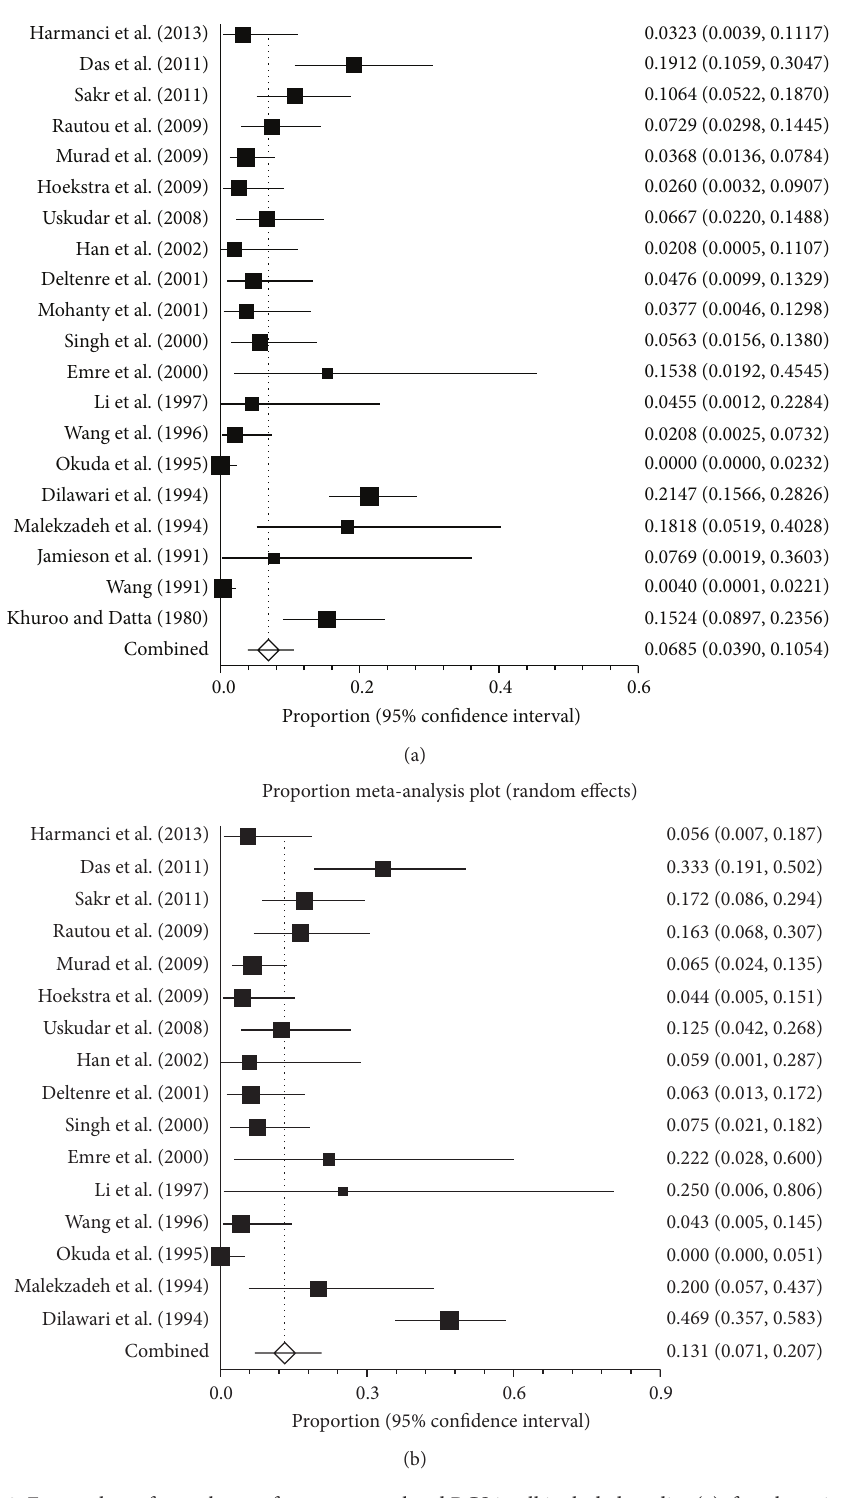
Figure 3: Forest plots of prevalence of pregnancy-related BCS in all included studies (a), female patients